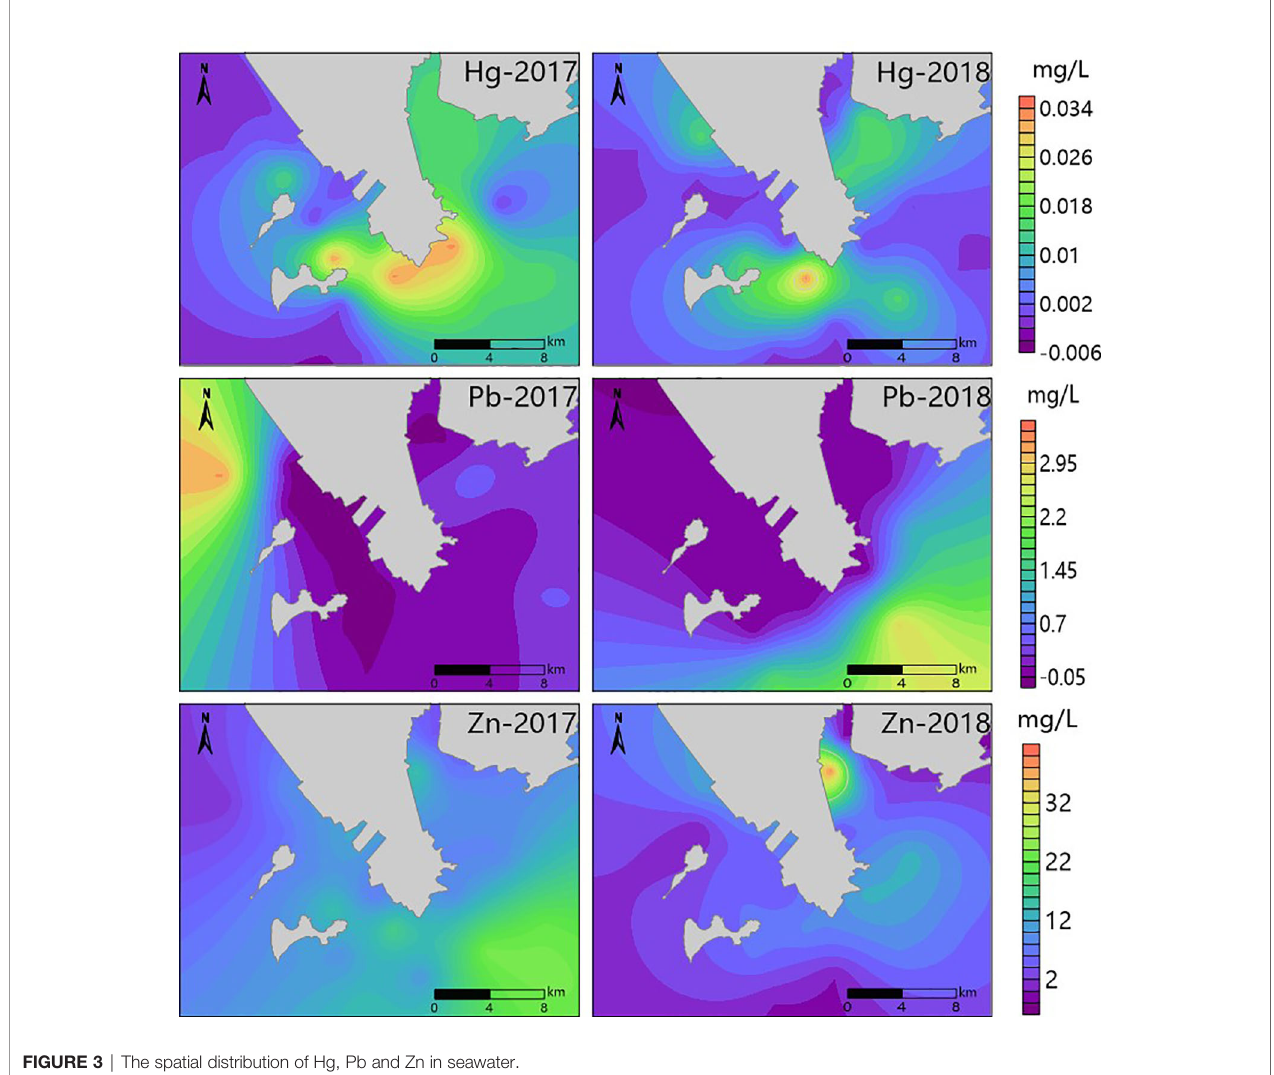
FIGURE 3 | The spatial distribution of Hg, Pb and Zn in